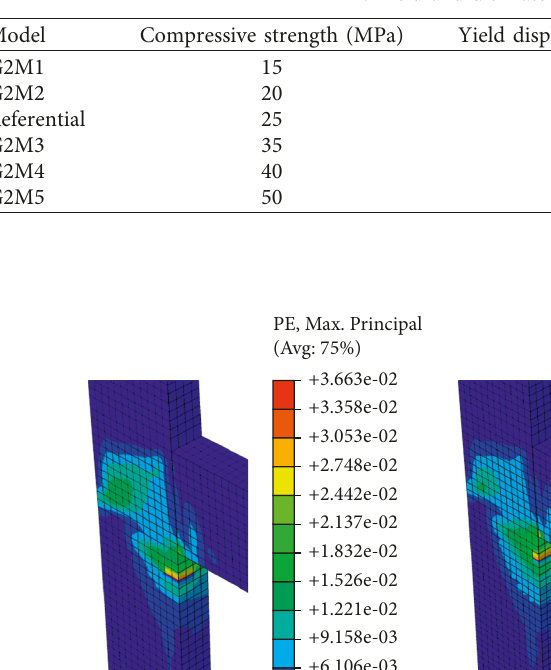
Table 11: Yield and ultimate displacement for ductility